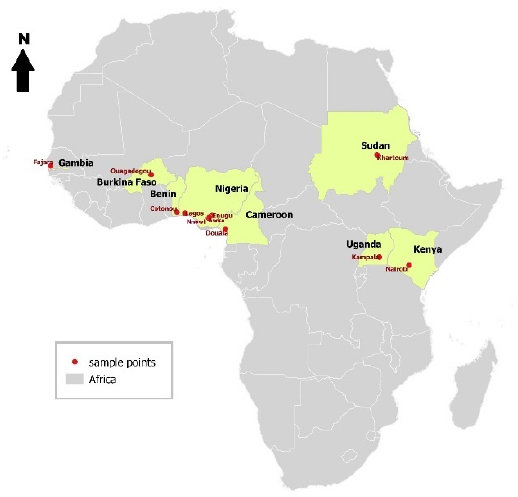
Figure 2. Countries involved in the one-year prospective ambient fine particulate matter measure- ment.